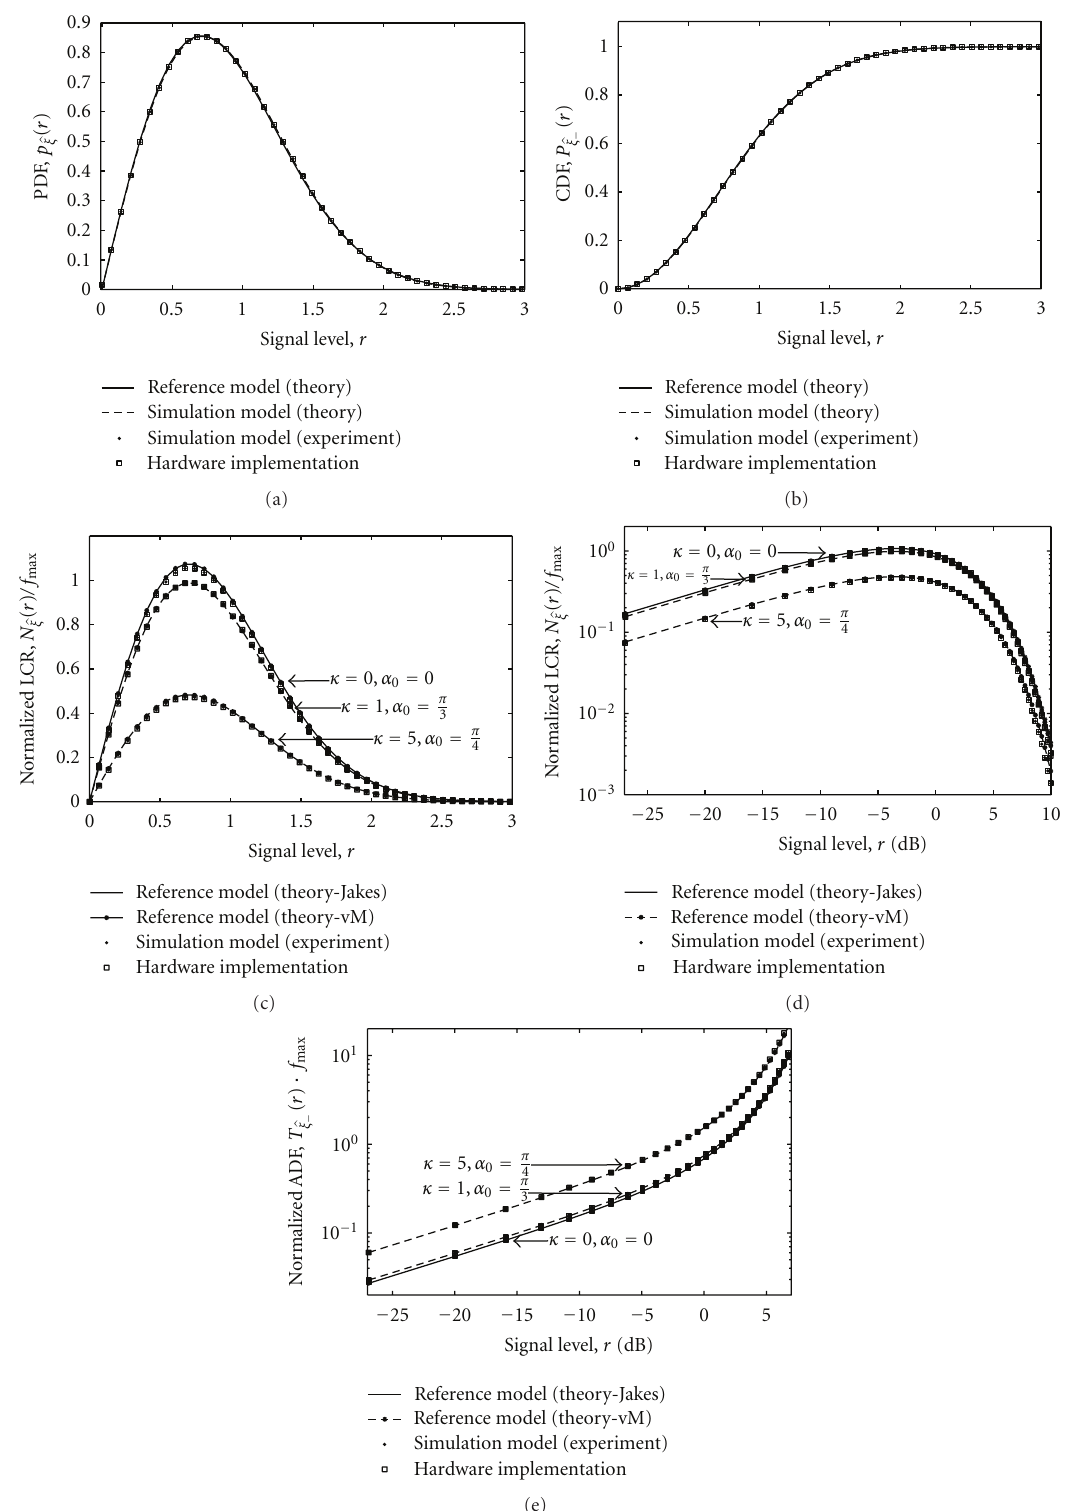
Figure 6: PDF, CDF, LCR, and ADF comparison results of the process generated envelope under non-isotropic scattering (von Mises PSD) using σ 2 0 = 0 . 5, N = 32, f max = 91Hz, and a parameter configuration pair of ( κ = 0, α 0 = 0), ( κ = 1, α 0 = π/ 3), and ( κ = 5, α 0 = π/